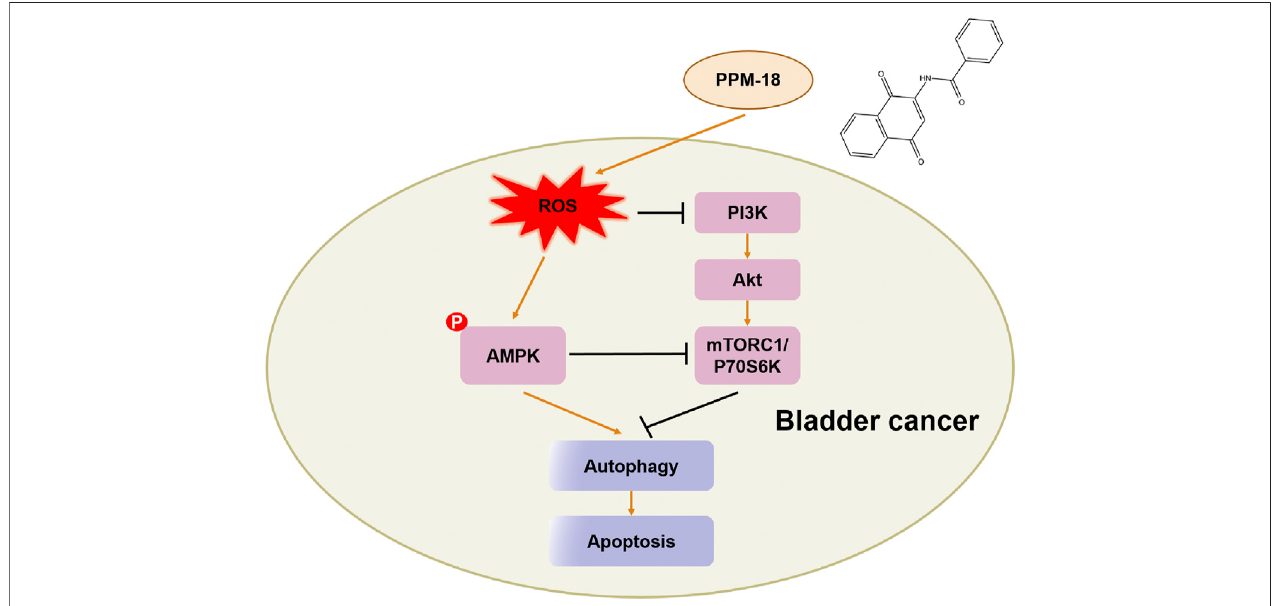
FIGURE 8 | Schematic diagram of signaling pathways associated with PPM-18 – induced autophagy and apoptosis in bladder cancer cells.